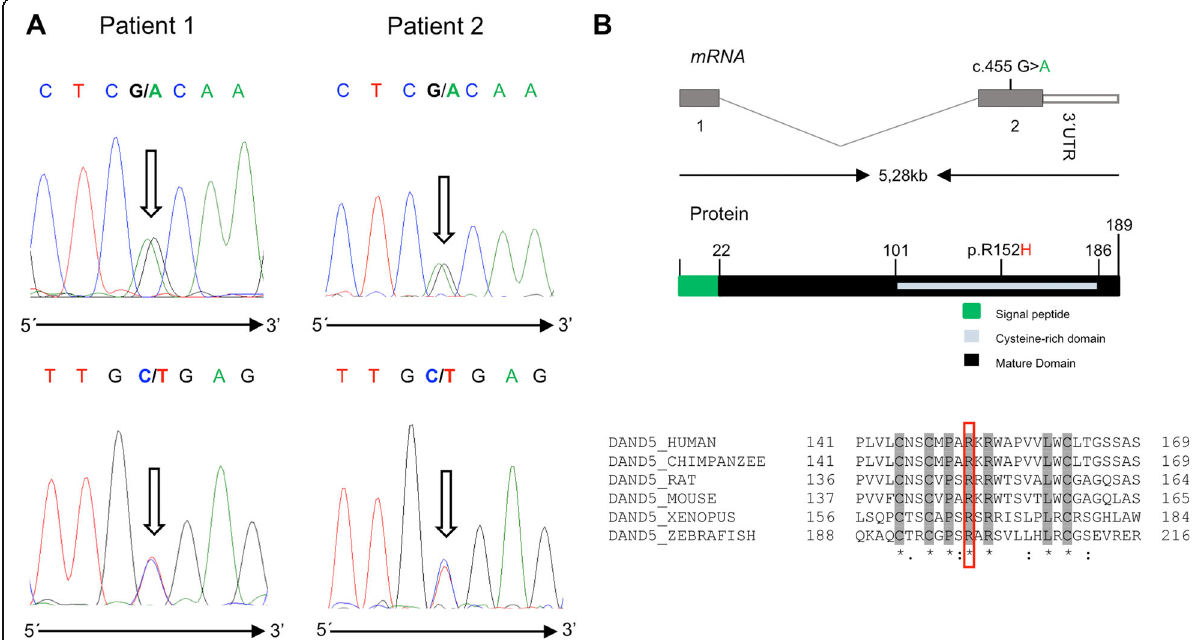
Fig. 1 a Forward and reverse DNA sequence chromatograms of patient 1 and 2 showing the c.455G > A allelic variant (highlighted by arrows ). b Schematic diagram of DAND5 structure with approximated localization of the variant identified in this study and cross-species sequence alignment of DAND5 showing the conservation of amino acid R152 (highlighted by red box )